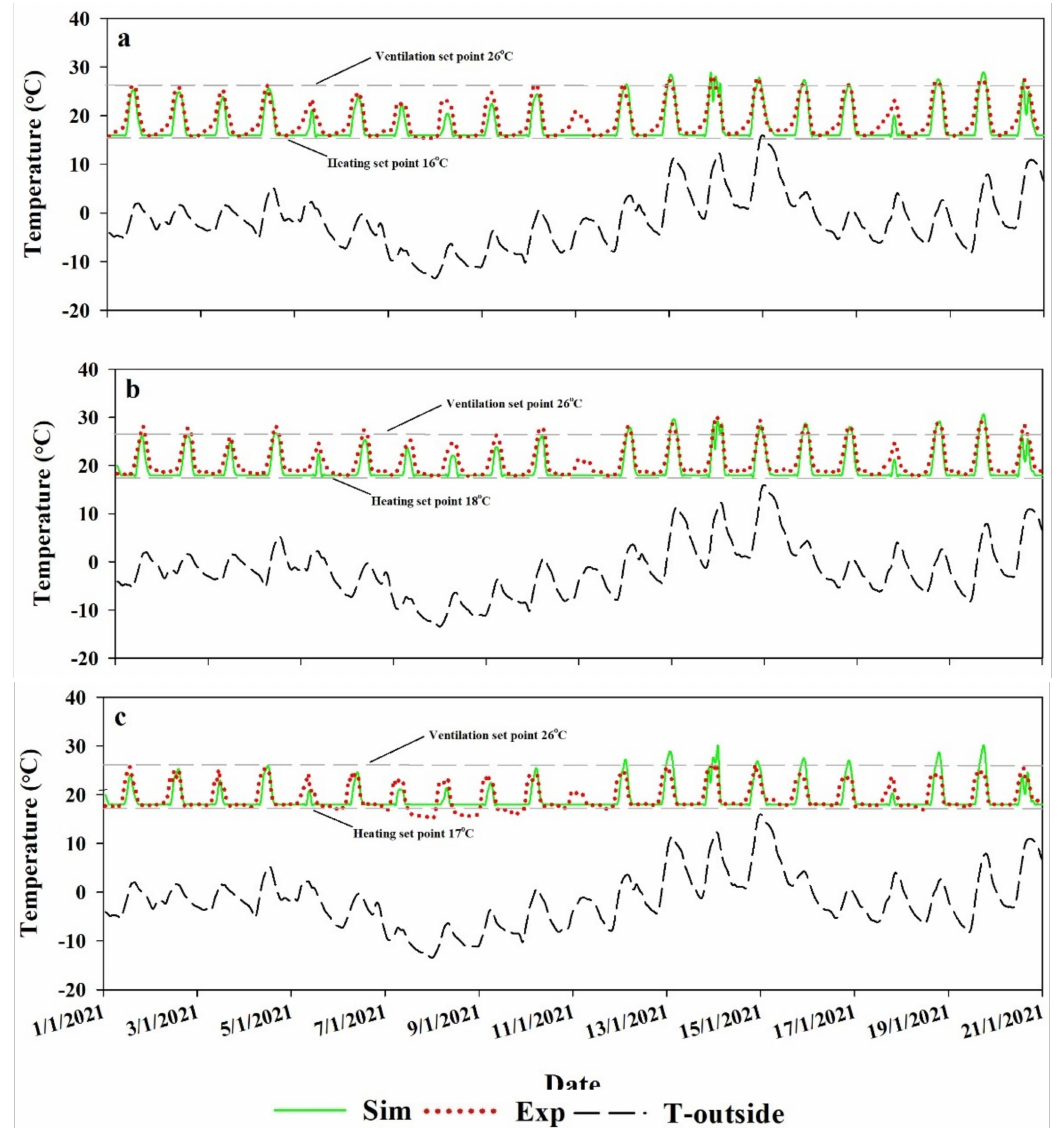
Figure 8. Experimental vs. simulated internal air temperatures ( a ) compartment 1, ( b ) compartment 2, and ( c ) compartment